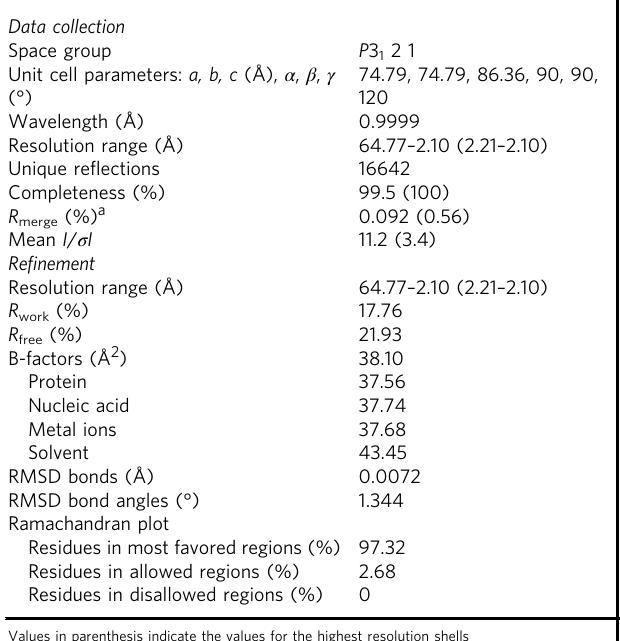
Table 1 Crystallographic data collection and re fi